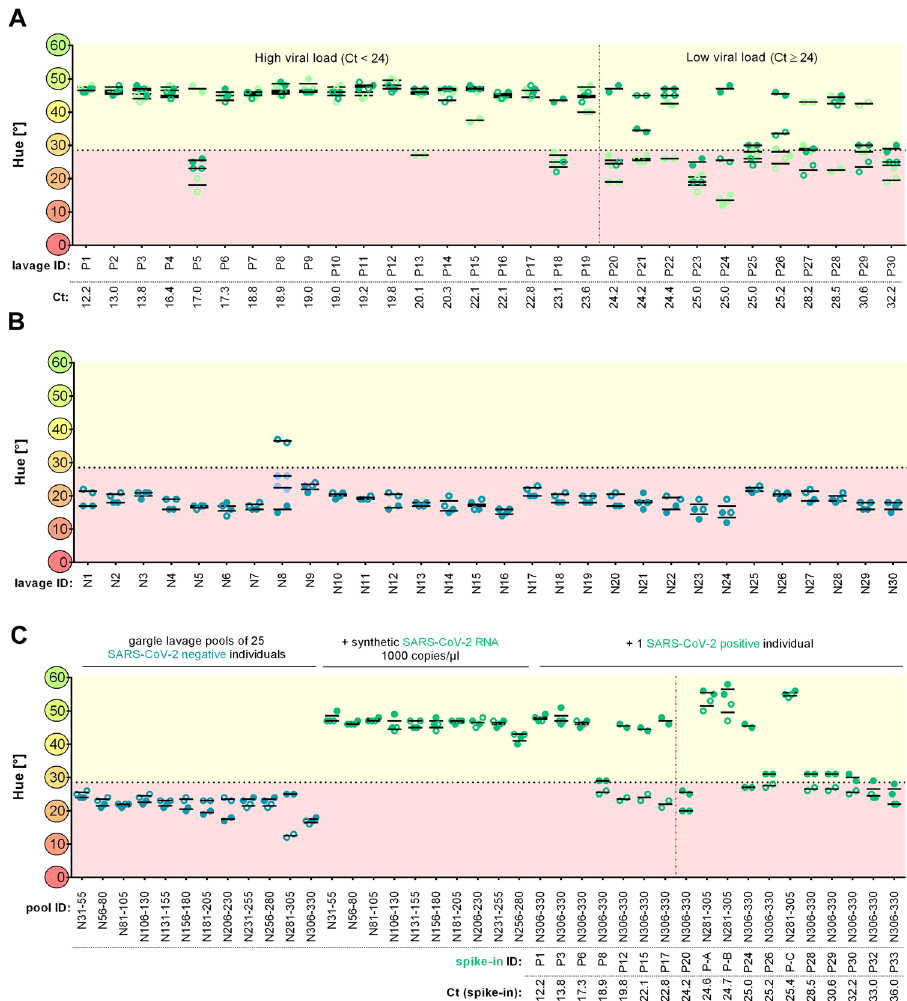
Fig. 2 Detection of SARS-CoV-2 in gargle lavage samples. Data obtained from healthy individuals are shown in blue while SARS-CoV-2-positive patient samples are depicted in green. Solid circles indicate values of the Orf1a assay while hollow circles denote values of the N gene assay. Assays with a hue >28.5° (dotted line) are considered positive. Repeated experiments are depicted in a light color and respective samples underwent an additional freeze/ thaw cycle. A Hue of individual SARS-CoV-2-negative gargle lavage samples after Cap-iLAMP measured in duplicates. B Hue of individual SARS-CoV-2- positive gargle lavage samples after Cap-iLAMP measured in duplicates. Ct values of individual patient gargle lavage samples obtained via RT-qPCR assay targeting the SARS-CoV-2 E gene are stated. C Hue of gargle lavage pools after Cap-iLAMP measured in duplicates. The Ct values of spiked-in positive samples are stated. A vertical red dotted line indicates the separation between samples with high viral loads (Ct < 24) and low viral loads (Ct ≥ 24). Samples with Ct < 24 are likely highly infectious. Source data are provided as a Source Data fi